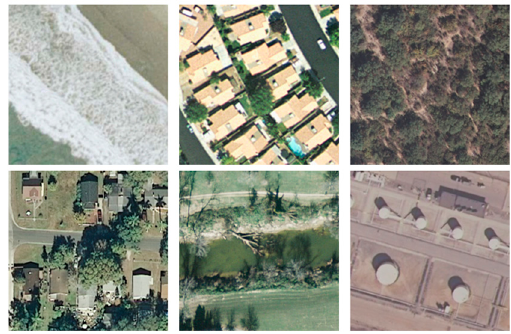
Figure 11. A sample diagram of the UCM dataset.